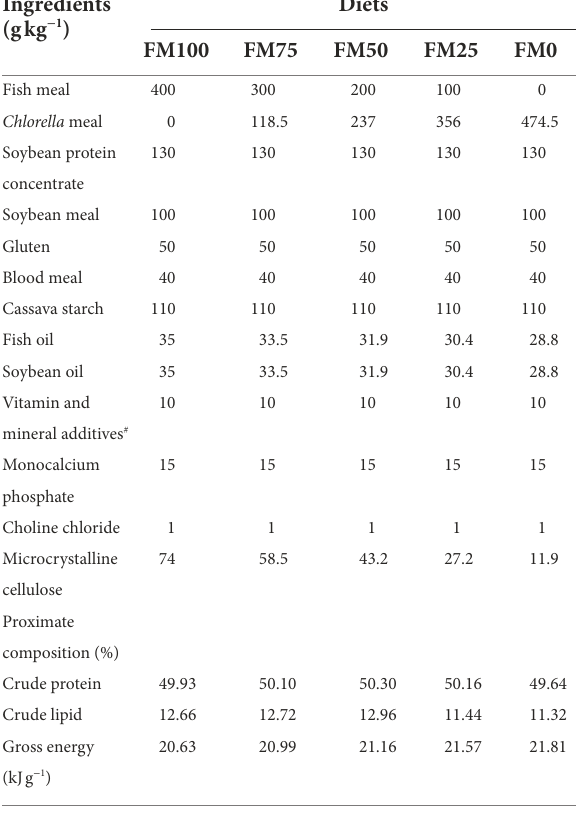
TABLE 1 Formulation and proximate analysis (g kg − 1 , dry matter basis) of the experimental diets. FM100 represents the fishmeal diet without Chlorella meal; FM75, FM50, FM25, and FM0 represent the fishmeal diet with 25, 50, 75, and 100% fishmeal replacement by Chlorella meal,